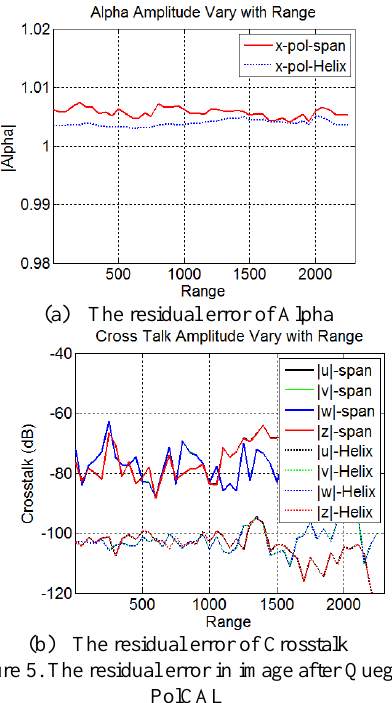
Figure 5. The residual error in image after